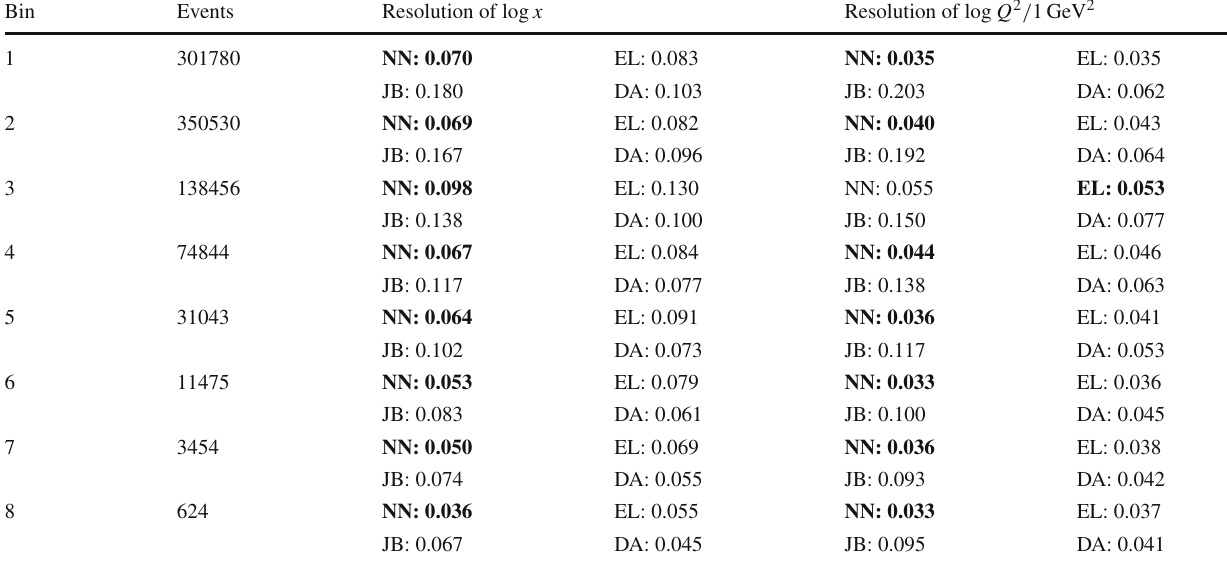
Table 4 Resolution of the reconstructed kinematic variables in bins of x and Q 2 . The resolution for x and Q 2 is defined as the RMS of